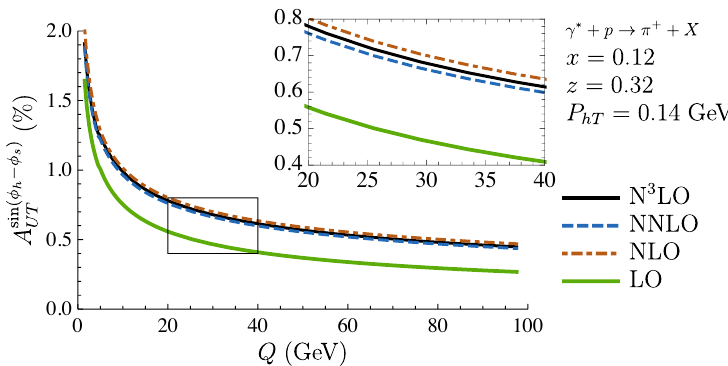
Figure 1. The dependence of the single-spin Sivers asymmetry on Q at fixed values of x = 0 . 12 , z = 0 . 32 , and P hT = 0 . 14 GeV (these values correspond to a particular bin of HERMES [35]). Different perturbative orders are compared. In all cases unpolarized TMD PDF, TMD FF, the Sivers function and the nonperturbative part of the CS kernel are the same. The change of the perturbative order influences the order of perturbative part of CS kernel, TMD anomalous